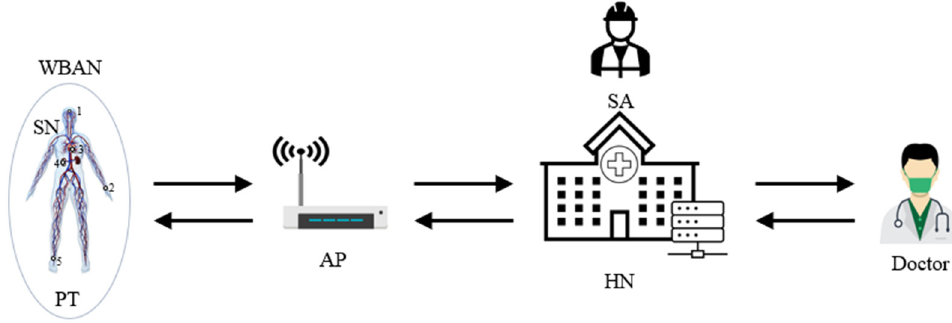
Figure 1. System configuration for remote healthcare